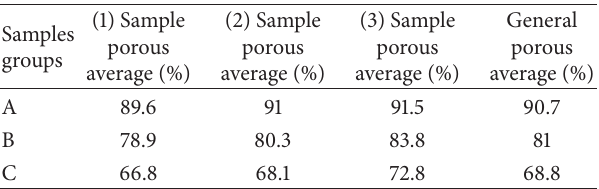
Table 2: Average porosities of the samples by groups.